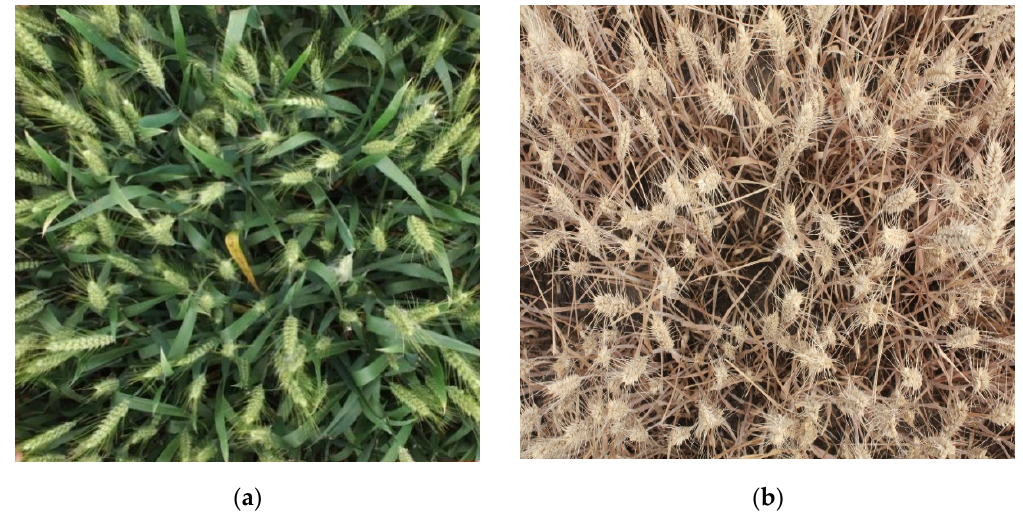
Figure 2. Digital images of wheat in key growth stages. ( a ) Partial Filling stage; ( b ) Mature stage. Table 2. Training database.